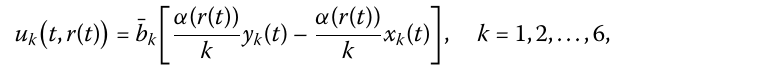
where W ( t ) is a scalar Brownian motion, β k (1) = (0.02 k ) 1/2 , β k (2) = (0.01 k ) 1/2 , k = 1,2,...,6. The state feedback controller is designed